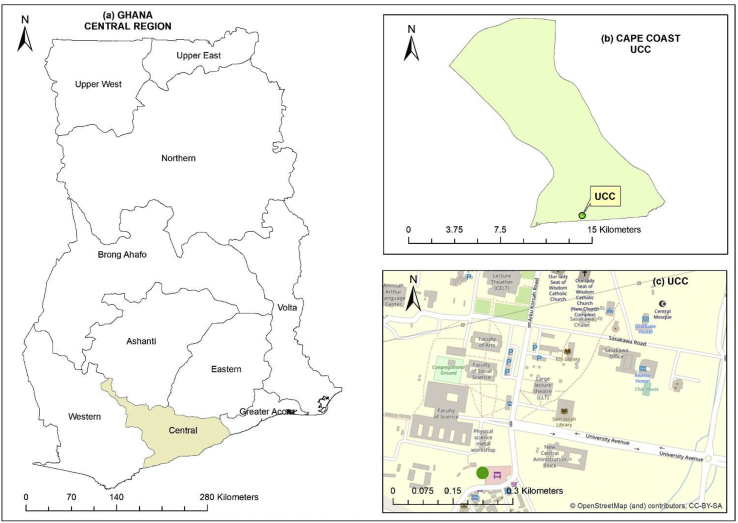
Overview of the deployment area at the University of Cape Coast (UCC) (a. overview of the central region location; b area covered by UCC; c. street view nearby the UCC). The green circle shows the location of the two co-deployed nodes ~10 cm apart (05°06′N 01°15′W).